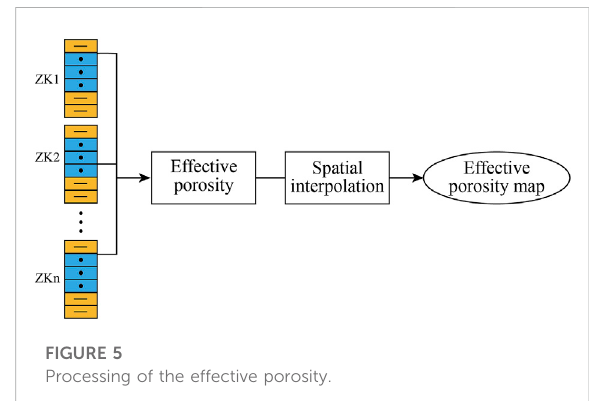
FIGURE 5 Processing of the effective